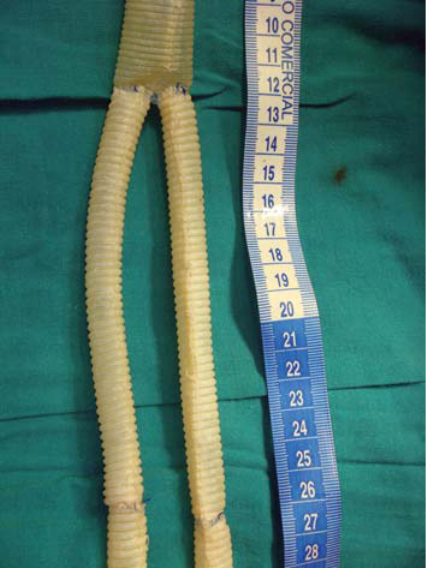
Fig.1 - Preoperative CT scan shows two fluid collections; the first located around the proximal part of aortic graft and the second around the left leg of the bifurcated graft